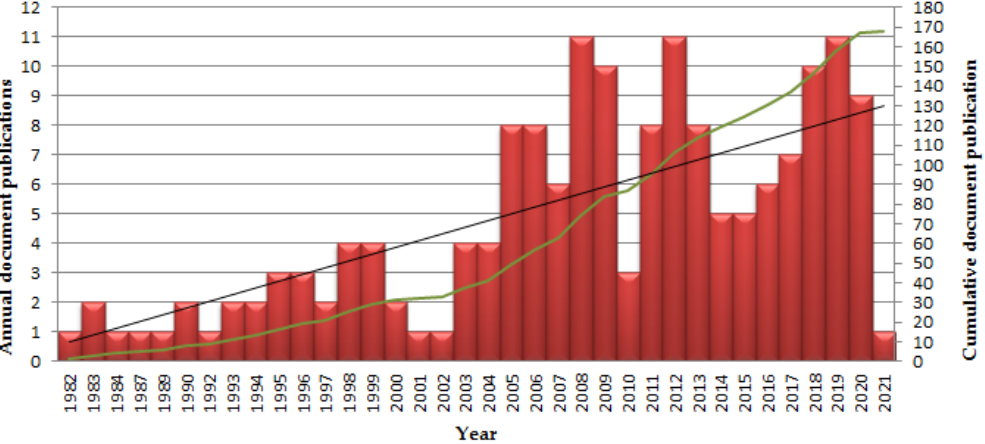
Figure 3. Distribution of the indexed research published between 1982 and 11 February 2021. While the numbers related to the cumulative line illustrated in green colour are represented on the right side, the amounts of annually published documents are shown on the left side of the graph. The black line represents the trend of the publications and the trend was computed as per linear regression. A linear regression analysis examines the statistical relationship between two or more quantitative variables in order to forecast one from the other(s) [36]. By looking at the trend, it is explicitly inferred from the chart that the rate of publications concerning delay analyses in the construction industry has an ac- celerating trend by years. Publications were observed to skyrocket in 2005. While the av- erage of annual publications concerning delay analyses in the construction industry was 2.2 until 2005, the average of yearly publications surged to almost 8 between 2005 and 2021. Bearing in mind that the study comprises the documents until 11 February 2021, 1 document published in 2021 does not represent the whole year. It is clear in Figure 3 that despite some interests for the studies concerning delay analysis topic until 2003, the trend has steadily accelerated since then, until 2020. Compared to the studies conducted in the 20th century, many more publications concerning delay analysis in the construction in- dustry have been conducted in the 21st century. This is in line with the argument that delay analysis topic has become an increasingly needed research field, and growth in the number of publications is likely to continue in order to meet the needs in the industry and academia. A scientometric analysis is needed in order to gain insight into state-of-the-art developments by processing very large amounts of heterogeneous data, which has been growing rapidly; thus, this enables the researchers and practitioners to get better decisions on delay analysis. 3.2. Main Research Interests Concerning Delay Analysis By mapping the term ‘Co - Item’ based on text data, the most repeated keywords were analysed via VOSviewer. According to the counting method, full counting was selected to identify occurrences of a term in all documents [37]. Afterwards, the minimum number of occurrences of a term was chosen as 20 in order to detect the most significant keywords and then the meaningful keywords were selected to identify the trend of delay analysis subjects in the construction industry. The most relevant repeated items in documents are illustrated in Figure 4 below.